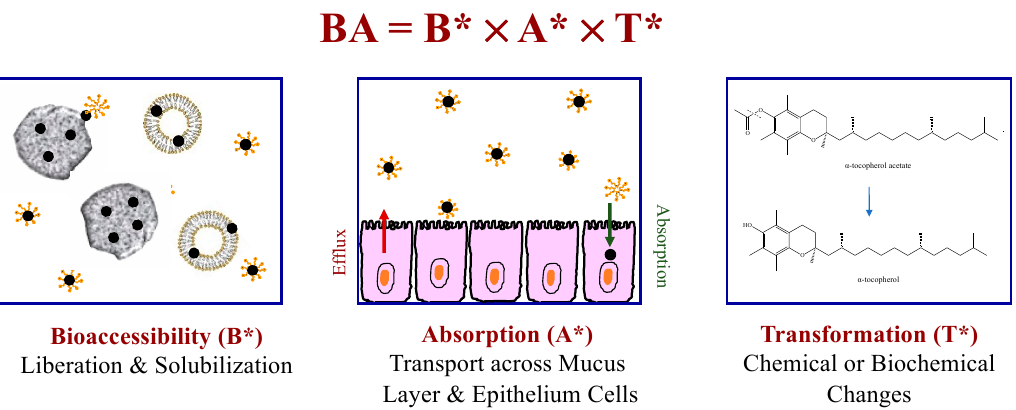
Figure 7. The oral bioavailability of a hydrophobic bioactive agent depends on liberation, solubilization, transport, transformation, and absorption processes.